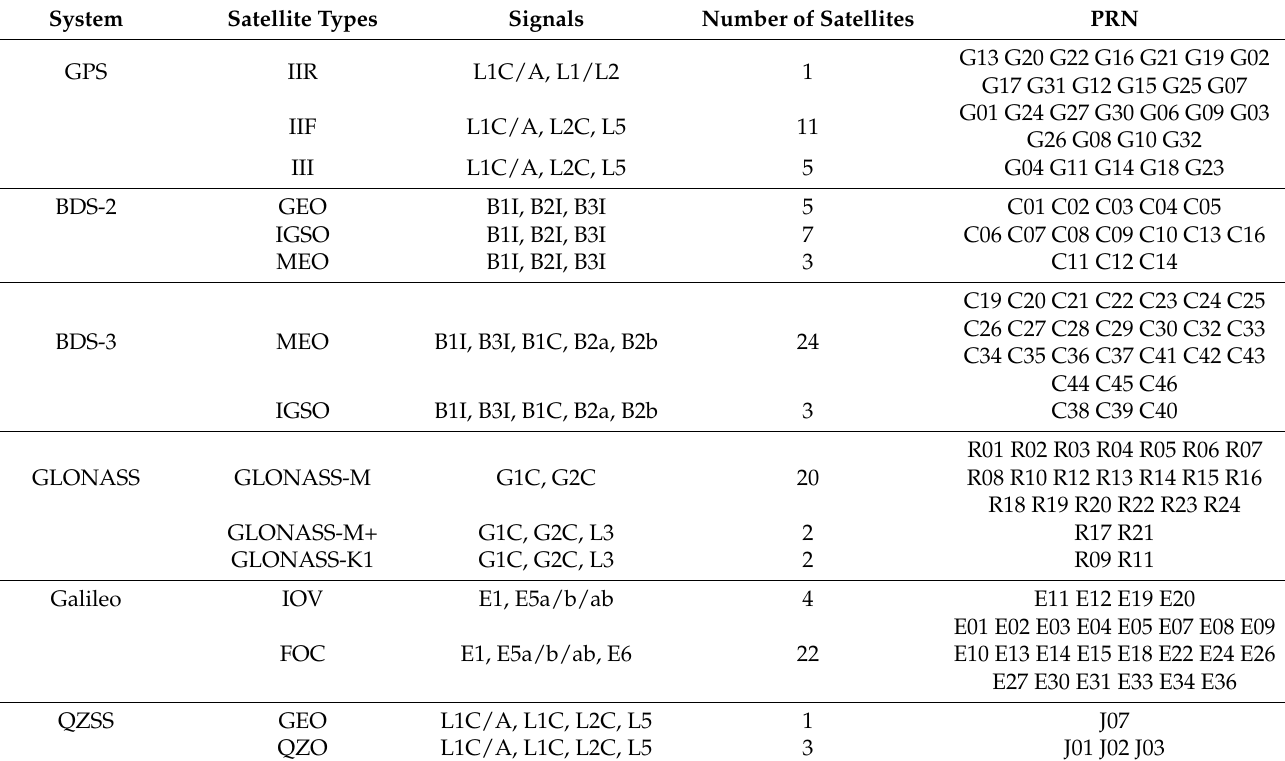
Table 1. Available satellites of each system at the end of April